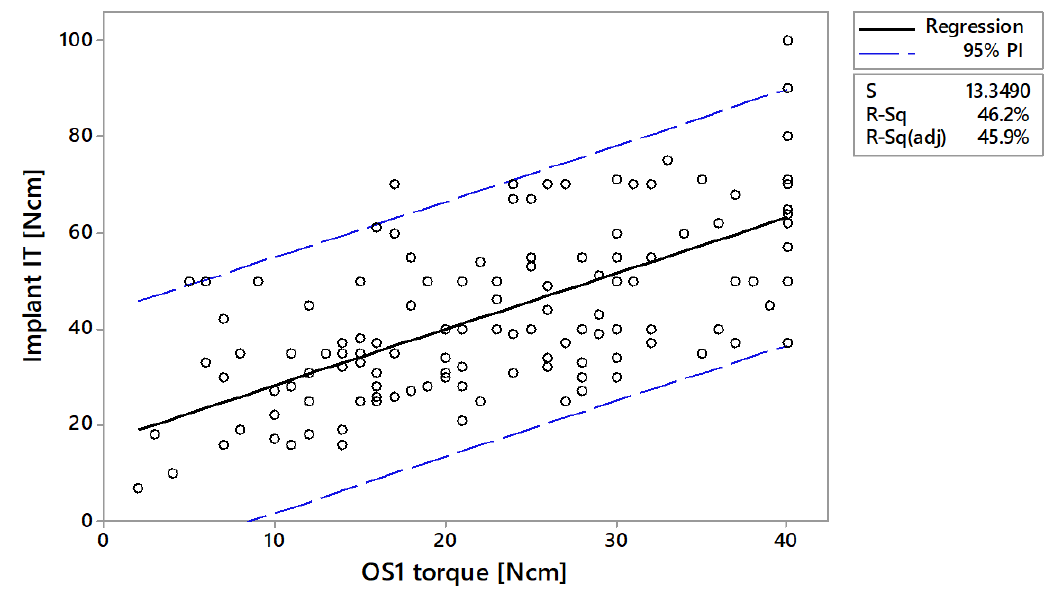
Figure 7. Linear regression of implant insertion torque versus OS1 torque in humans ( n = 145). Table 3. Mean ± standard deviation (SD) and 95% prediction intervals (PI) of implant insertion torque for different OS1 torque ranges in minipigs and human subjects (Figure S5).